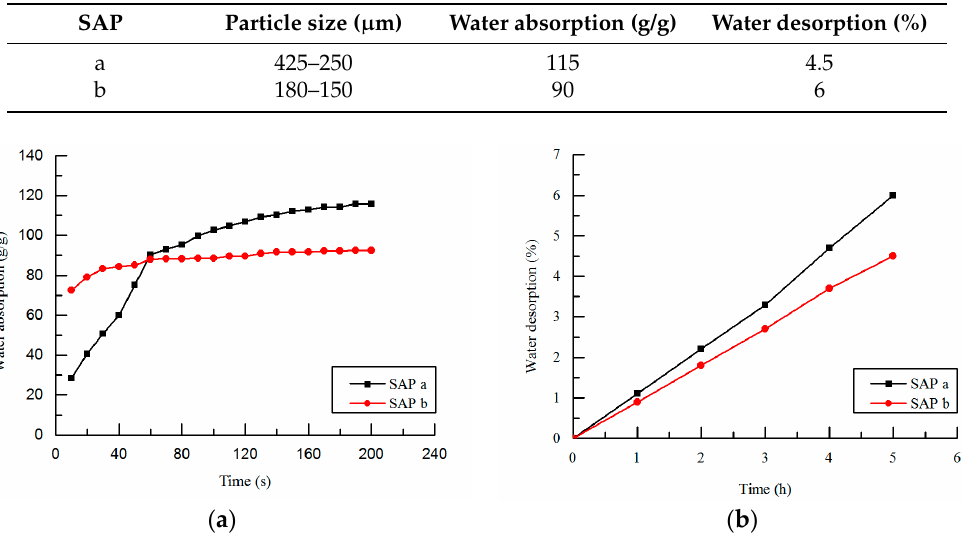
Figure 1. Time dependent water absorption and desorption behavior of superabsorbent polymer (SAP): ( a ) water absorption; ( b ) water desorption.